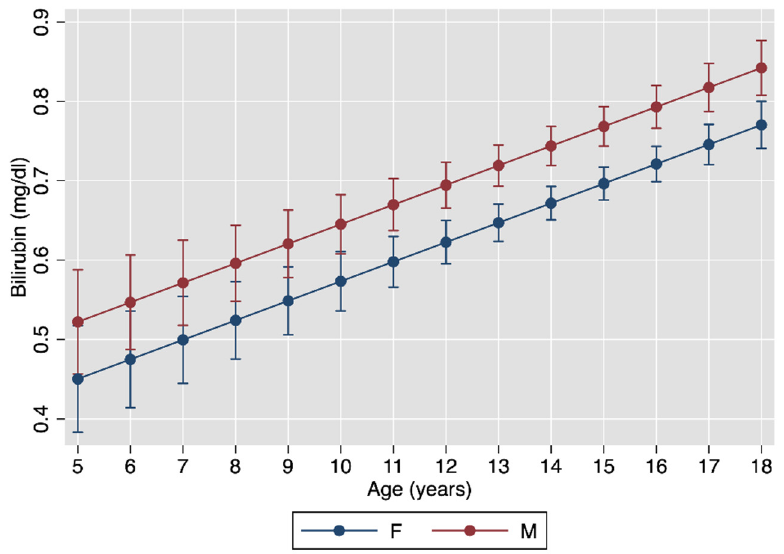
Figure 1. Association between bilirubin and age. See Table 2 for the underlying linear regression model.